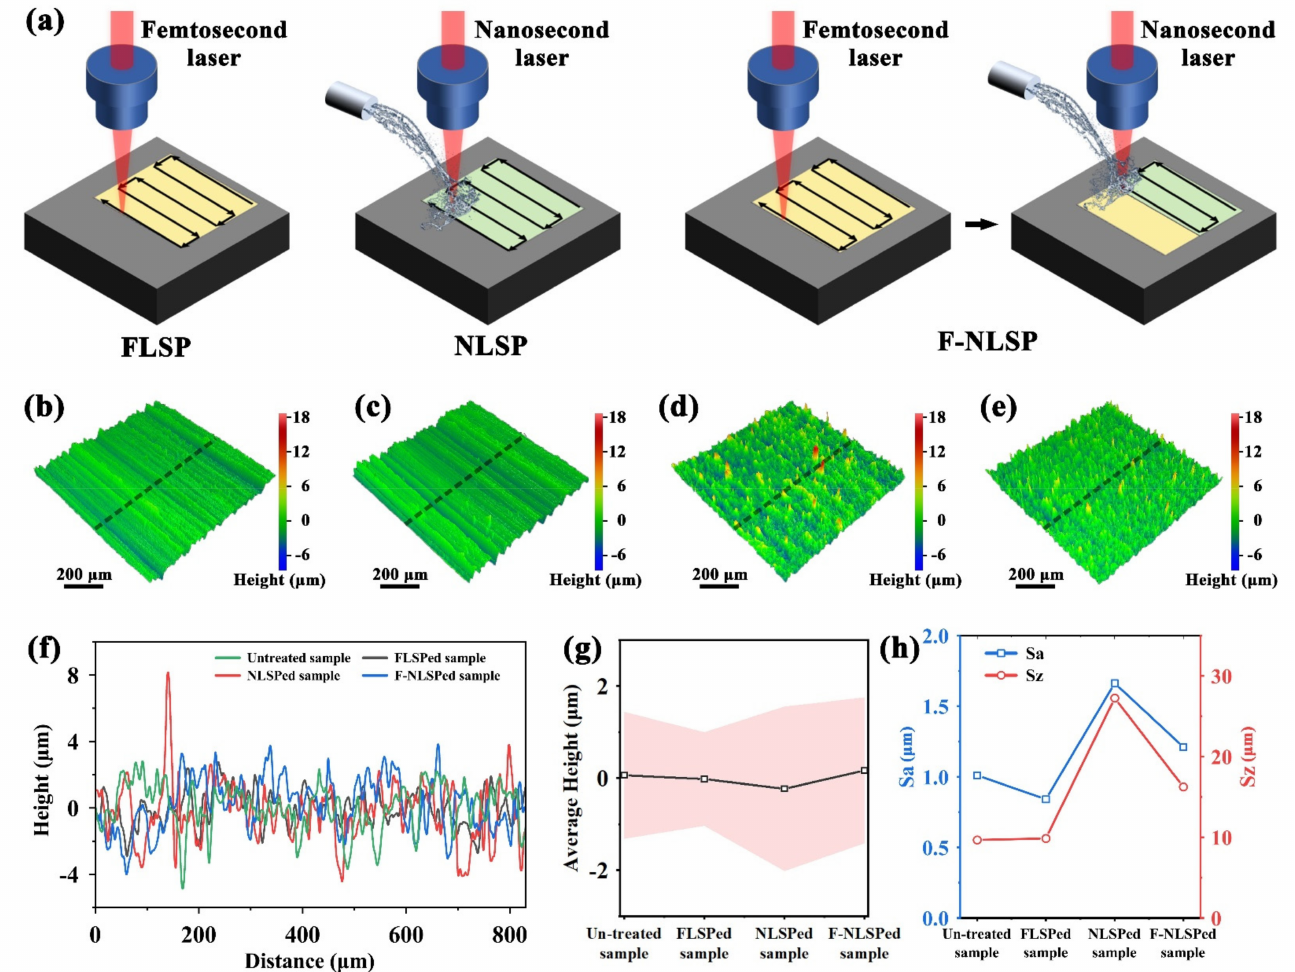
Figure 1. Surface morphology characterizations of un-treated and LSPed surfaces. ( a ) Schematics of FLSP, NLSP, and F-NLSP, respectively; Surface morphologies of ( b ) untreated, ( c ) FLSPed, ( d ) NLSPed, and ( e ) F-NLSPed samples, respectively; ( f ) Heights changes along different detecting lines in ( b – e ); ( g ) Changes of average height with the corresponding variances; ( h ) Surface